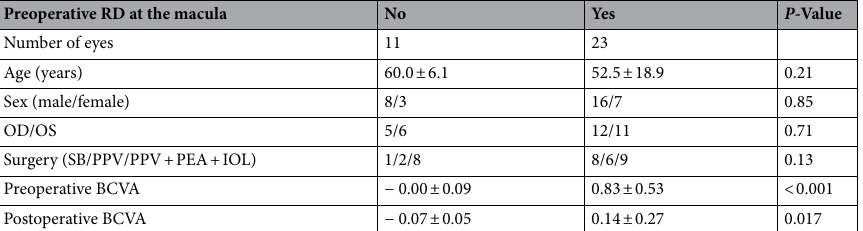
Table 1. Characteristics of patients with rhegmatogenous retinal detachment. BCVA best corrected visual acuity, IOL intraocular lens, OD oculus dexter, OS oculus sinister, PEA phacoemulsification and aspiration,